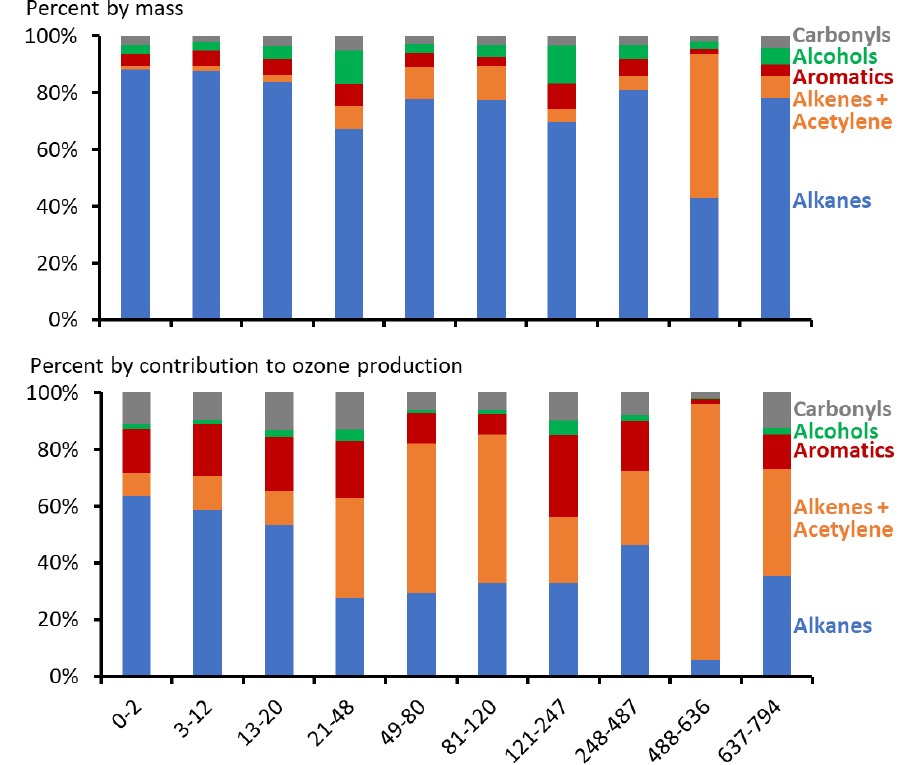
Figure 6. Average contribution of organic compound types to total organic compound mass ( top ) and ability of organics to produce ozone ( bottom ; calculated from maximum incremental reactivity [63]). Data are 10-percentile bins of the number of producing oil wells within a 10 km radius.